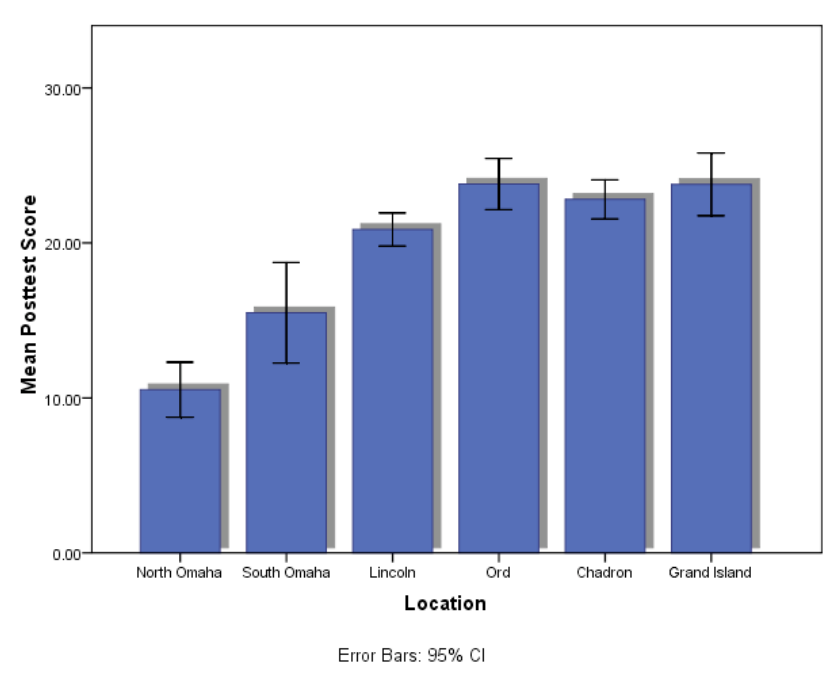
Posttest Means by